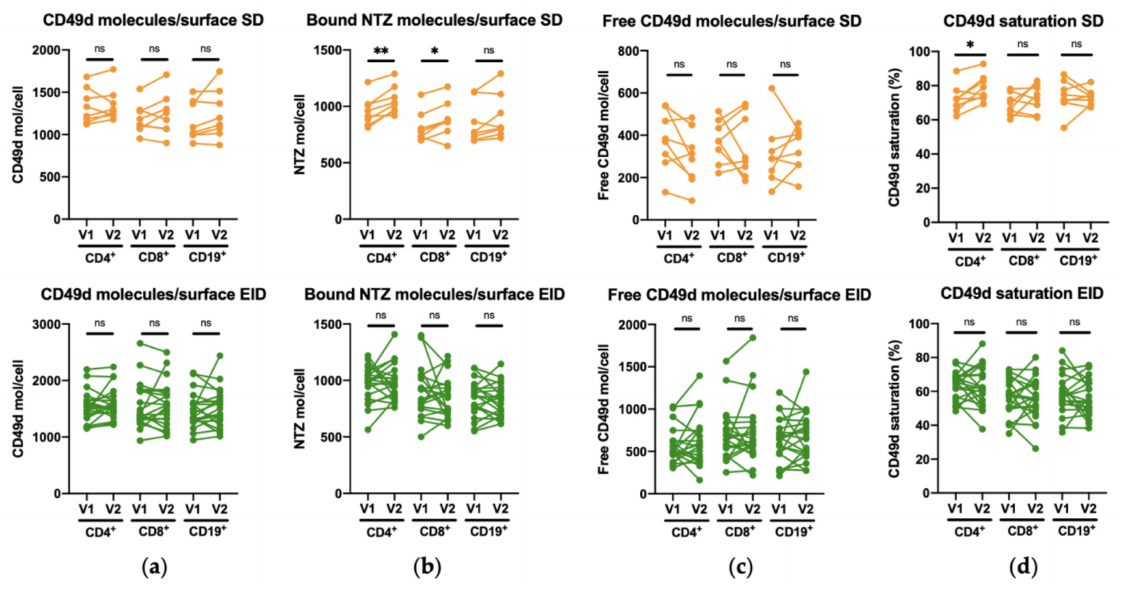
Figure 1. Comparison between the first extraction (V1) and the second extraction (V2) within CD4 + and CD8 + T lymphocytes, and CD19 + B lymphocytes for the CD49d surface molecules levels and saturation percentage in RRMS patients under Natalizumab treatment in SD or EID. Mean of ( a ) CD49d molecules/cell surface, ( b ) bound NTZ/cell surface, ( c ) free CD49d molecules/cell surface, and ( d ) CD49d saturation percentage in CD4 + and CD8 + T lymphocytes, and CD19 + B lymphocytes in the SD ( n = 8) and EID ( n = 21) groups. Each dot represents the number of PE molecules per cell for each patient in either V1 and V2, translated into the levels of the corresponding antibodies (anti-CD49d PE and huIgG4 Fc PE). EID, extended interval dosing; NTZ, natalizumab; SD, standard dosing. ns: p > 0.05, * p < 0.05, ** p < 0.01.